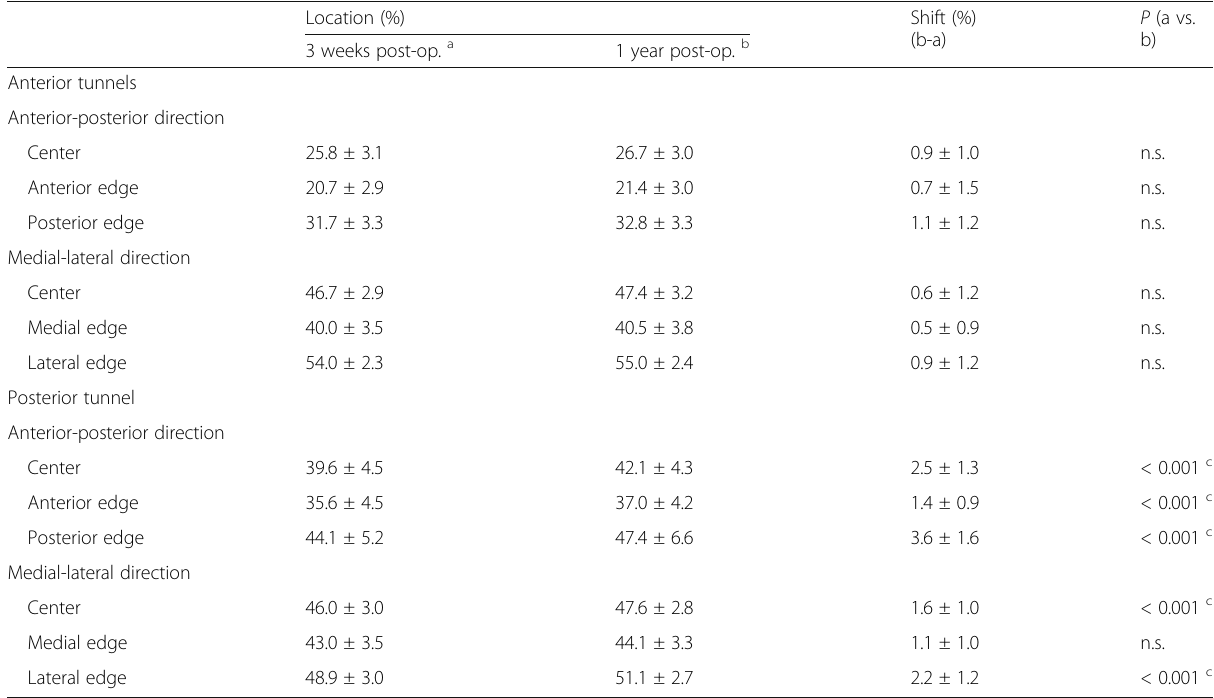
Table 2 Location of the center and edge of the tibial tunnel footprint Location (%) Shift (%)